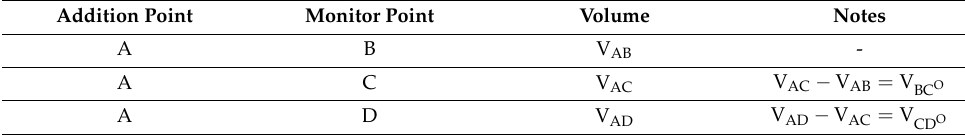
Figure 6. Schematic diagram of unit subtraction tracer measurement method. Table 8. Simulation performed for the volume subtraction